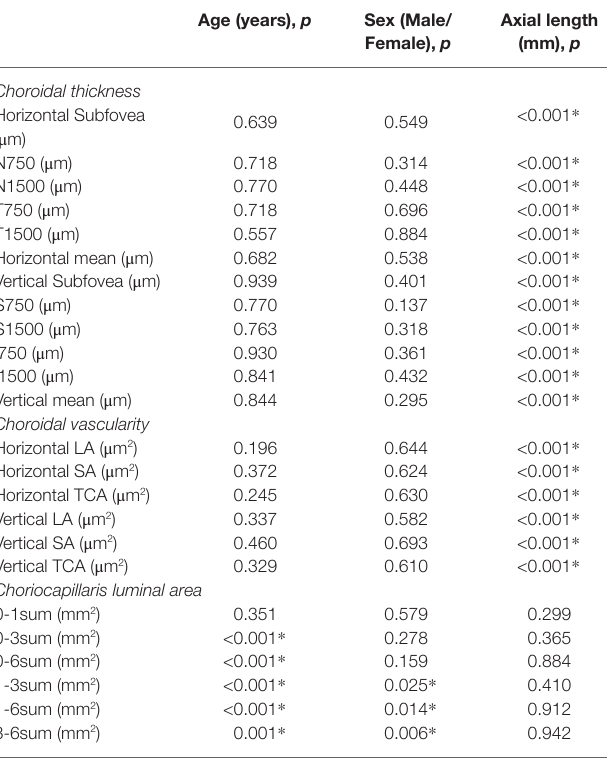
association between choroidal parameters and age, sex has been adjusted. For the association between choroidal parameters and sex, age has been adjusted. For the association between choroidal parameters and axial length, age and sex have been adjusted. * Significance of